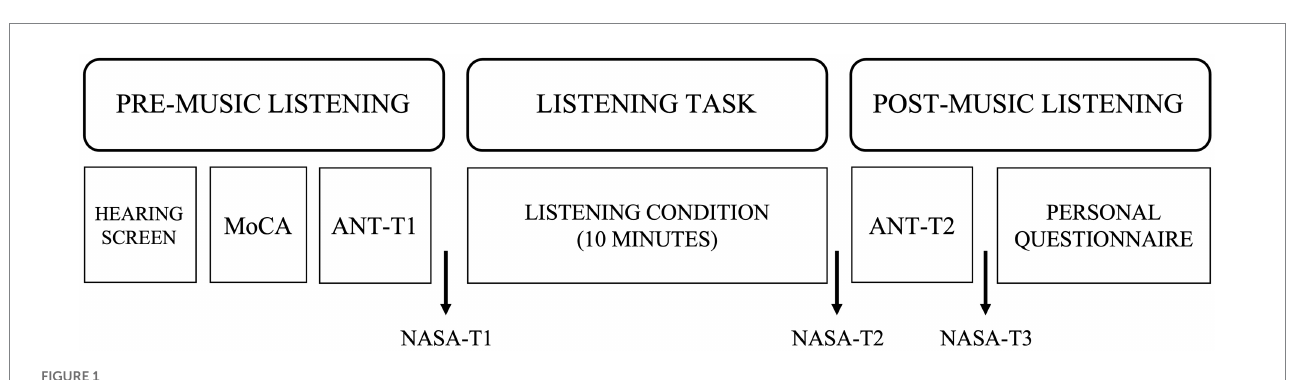
FIGURE 1 Visual representation of the experimental